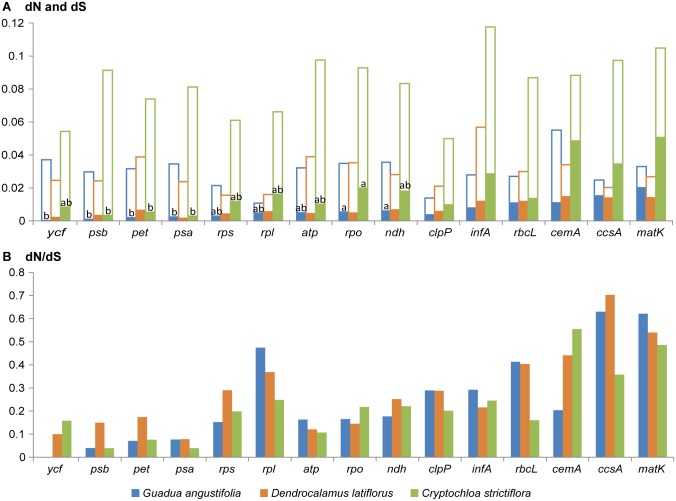
Nonsynonymous substitution (dN), synonymous substitution (dS), and dN/dS values for individual genes or gene groups.(A) dN and dS values are shown as overlapping bars; hollow bars indicate dS values, and solid bars indicate dN values. (B) dN/dS values.